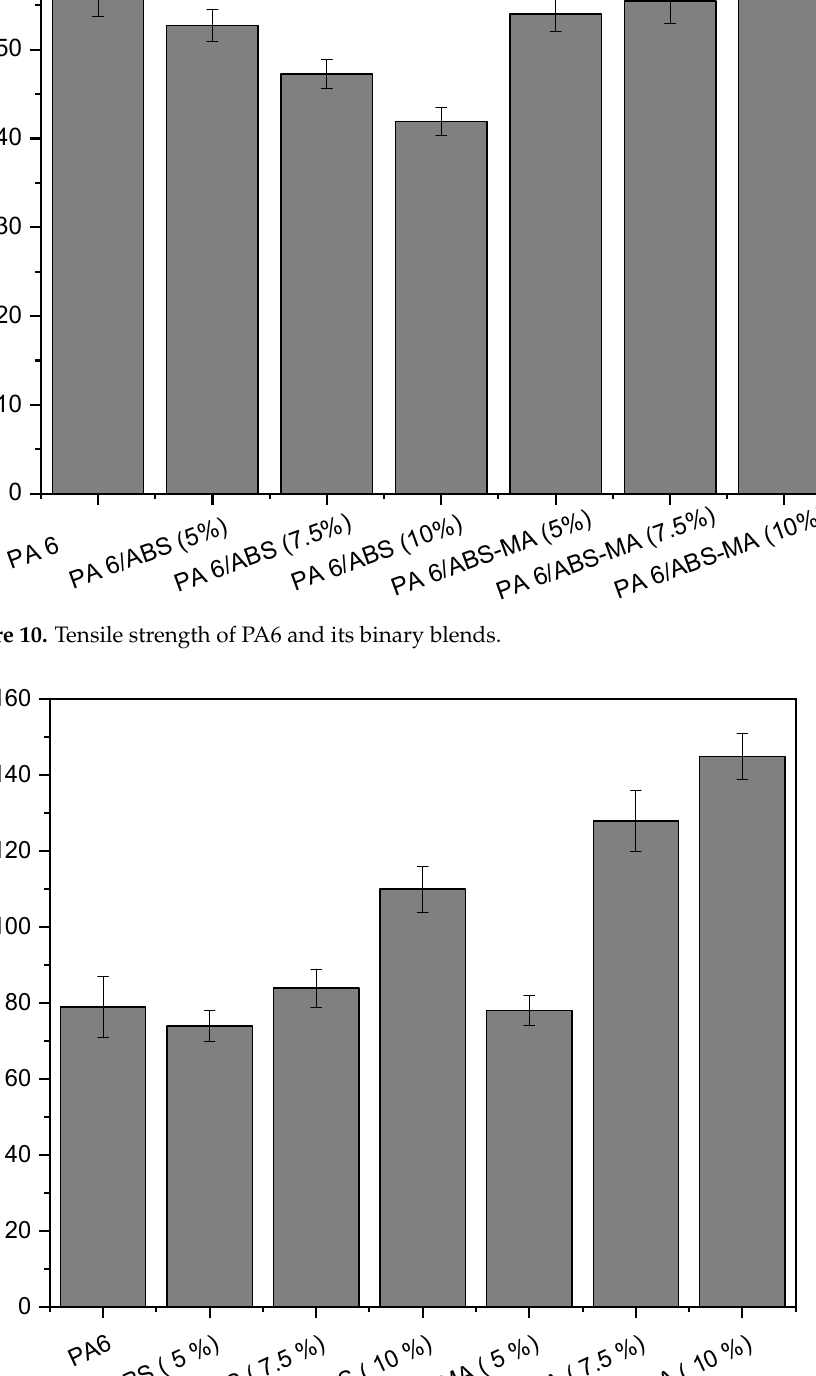
Figure 11. Elongation at break of PA6 and blends as a function of ABS and ABS-MA concentrations.